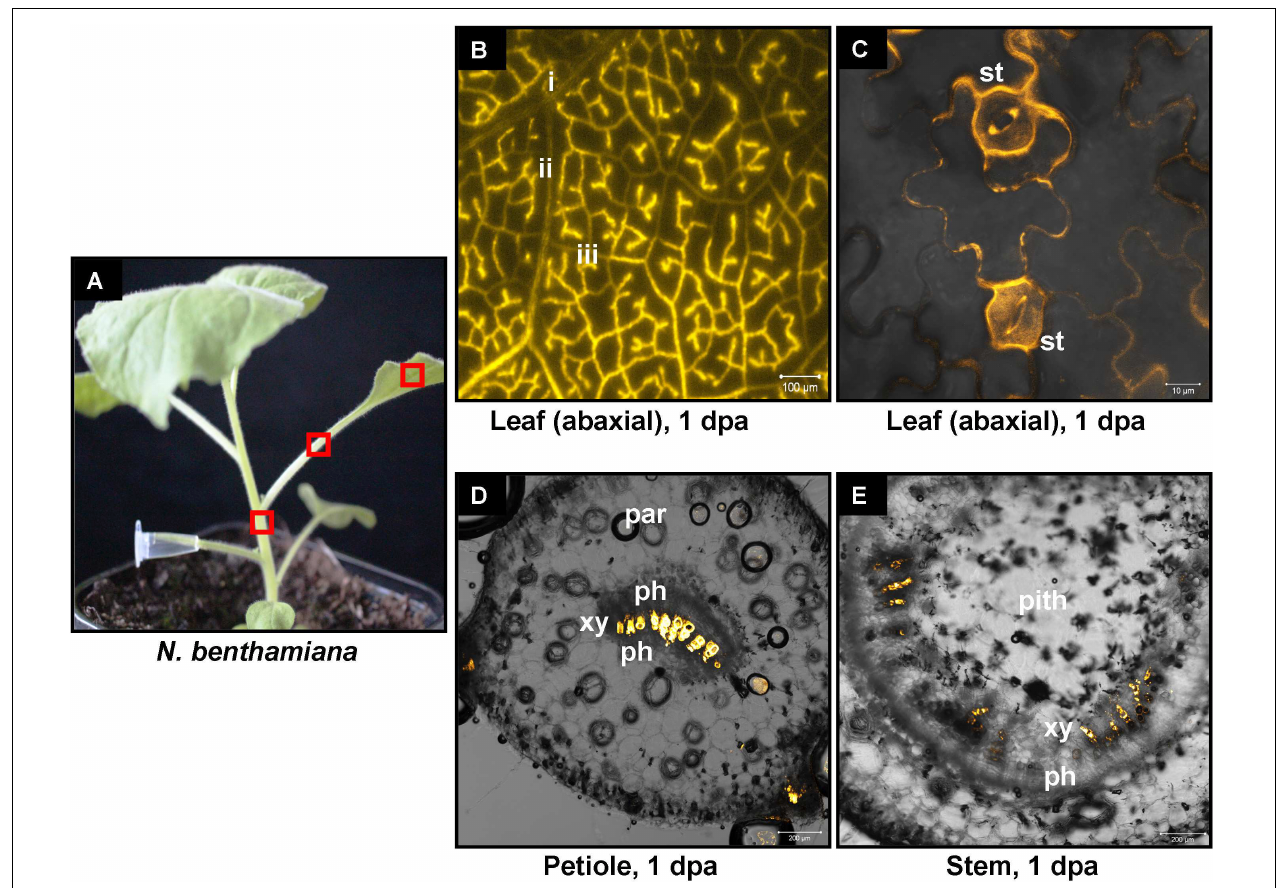
FIGURE 5 | Delivery of CY3-labeled 22-nt siRNA by petiole absorption to N. benthamiana. (A) Red boxes indicate parts of the plant that were subjected to microscopy 1 dpa. (B) Fluorescence microscopy of the abaxial side of a distant leaf. (C) Confocal microscopy of the abaxial side of a distant leaf. (D) Confocal microscopy of the petiole (cross section) of a leaf. (E) Confocal microscopy of the stem (cross section) above the site of CY3-labeled siRNA application. Abbreviations: i, class I vein; ii, class II vein; iii, class III vein; st, stomata; xy, xylem; ph, phloem; par, parenchymatic